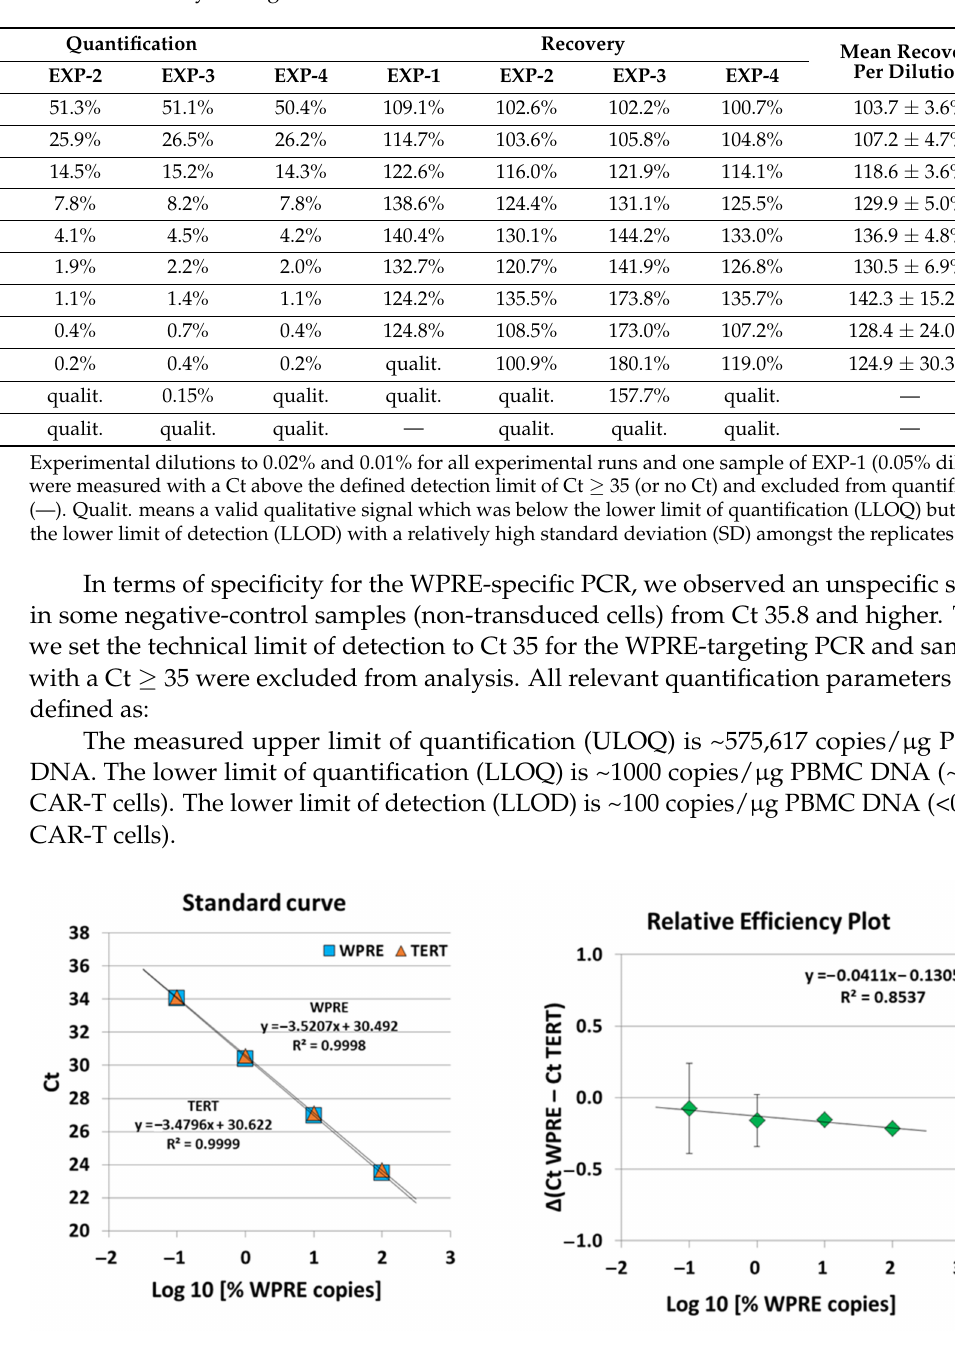
Table 1. Recovery testing.